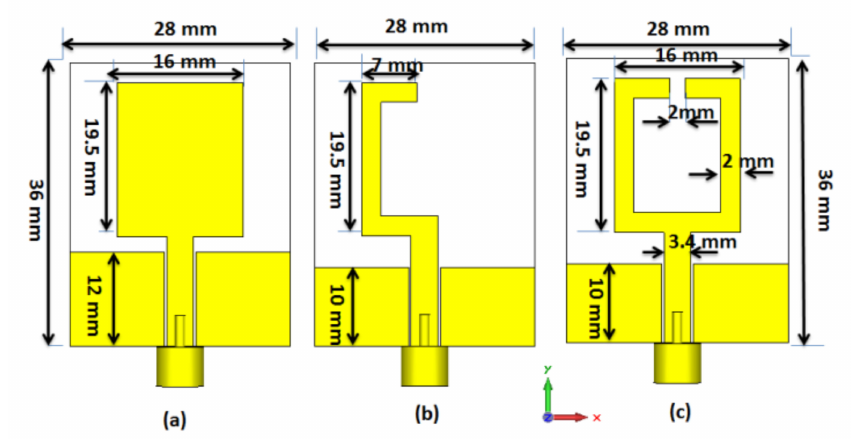
Figure 1. CPW monopole antenna structure development: ( a ) Antenna 1 ( b ); antenna 2; ( c ) antenna 3.